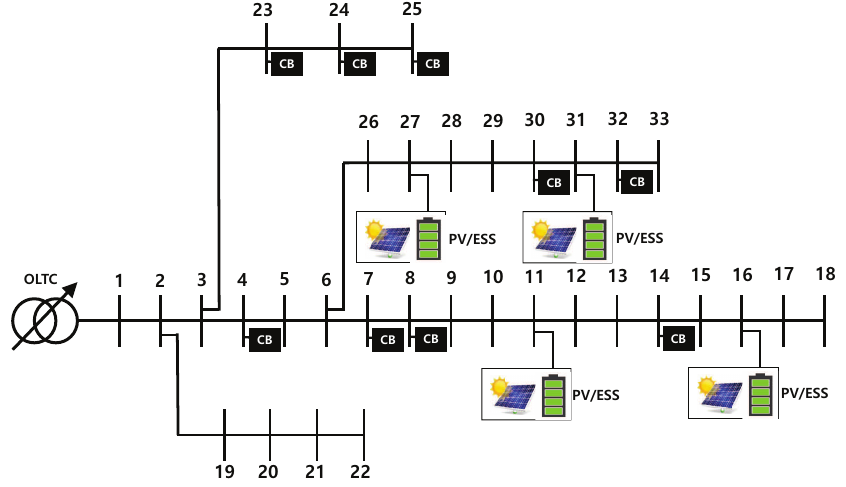
Figure 3. Modified IEEE 33-bus system with on-load tap changer (OLTC), capacitor banks (CBs), PV systems and